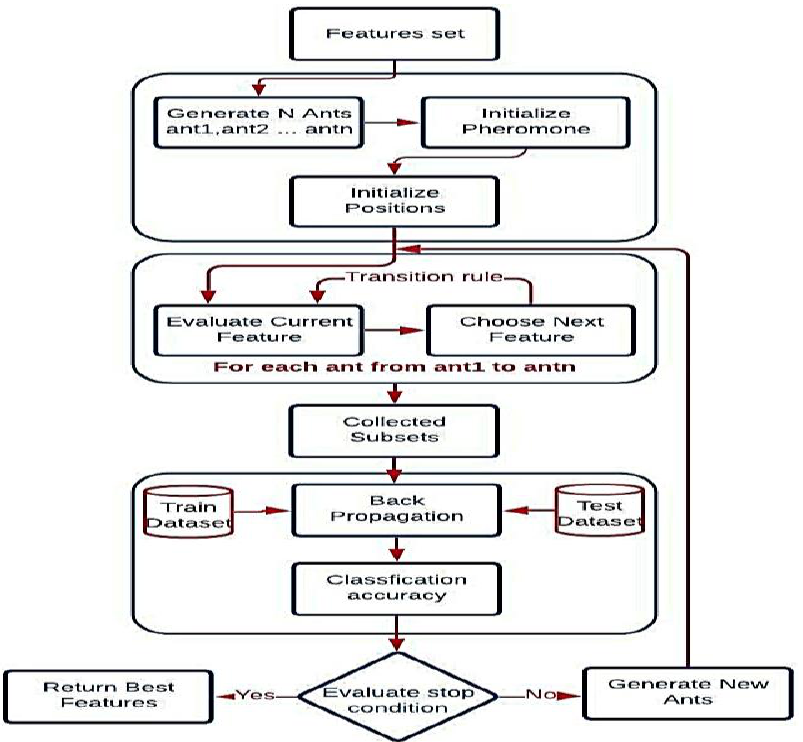
Figure 4 . ACO for the feature selection process . Figure 4. ACO for the feature selection